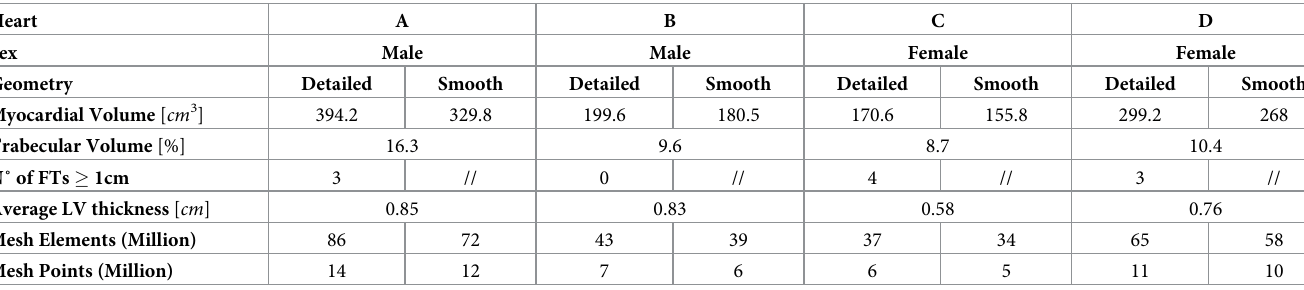
Table 1. Detailed and smooth biventricular models